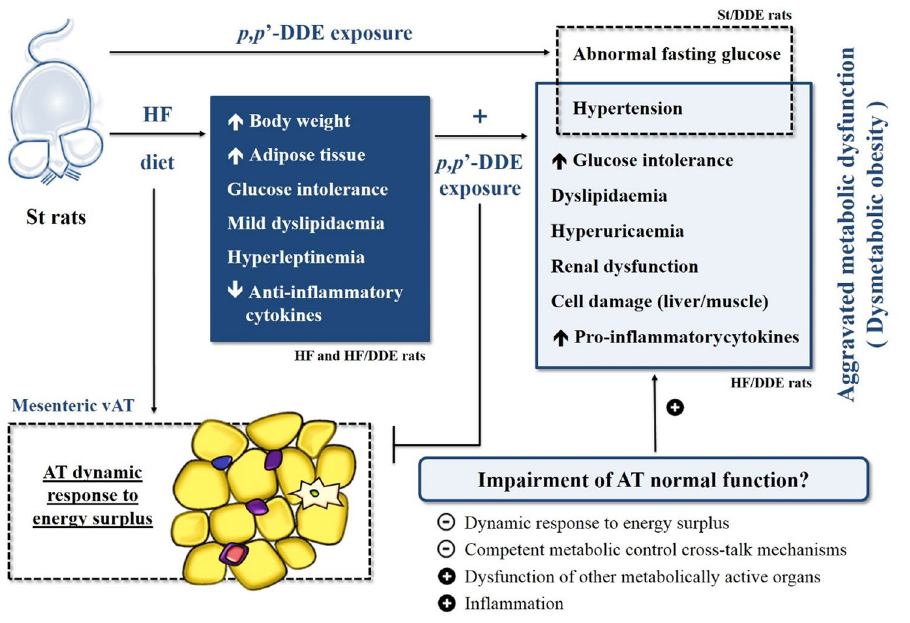
Figure 8. Schematic representation of the effects observed with the different treatments, whereby p , p ’-DDE exposure appears to have an effect in metabolic syndrome evolution and dysmetabolic obesity, namely by exacerbating the effects of HF, in which the impairment of AT normal function seems to play a central role. St, standard diet; HF, high fat diet; p , p ’-DDE, p , p ’-dichlorodiphenyldichloroethylene; vAT, visceral adipose